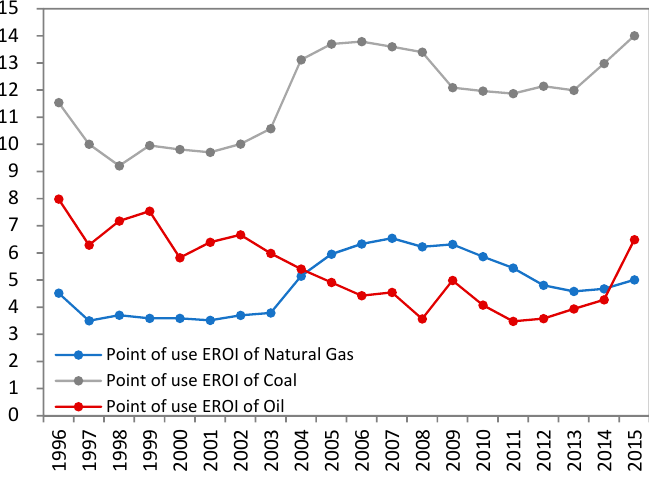
Figure 5. EROI ST and EROI POU of coal in China from 2000 to 2013.